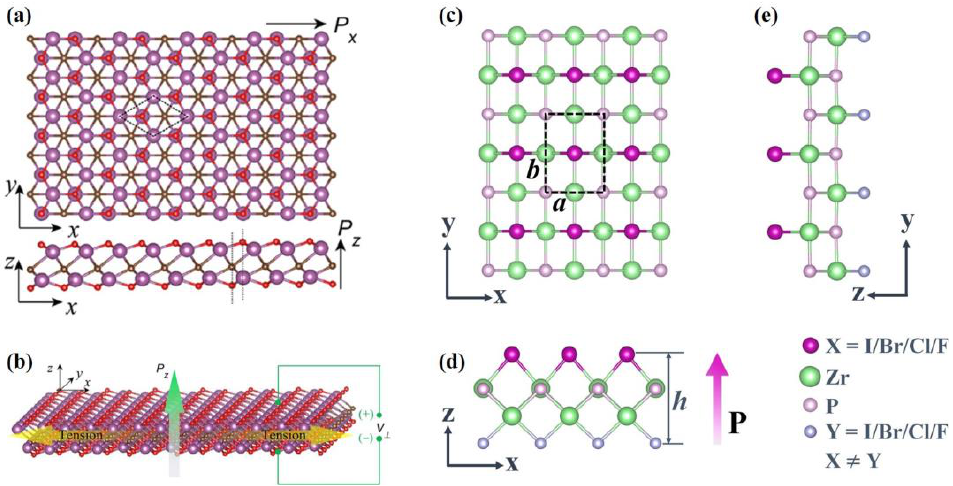
Figure 14. The schematic diagram of the ultrathin out-of-plane films [86,89]. ( a ) Top and side view of Sc 2 CO 2 MXene. Reprinted from [86], copyright 2019, with permission from Elsevier. ( b ) A Sc 2 CO 2 MXene piezoelectric cantilever. Reprinted from [86], copyright 2019, with permission from Elsevier. ( c ) Top view of the Zr 2 P 2 BrCl monolayer. Reprinted from [89], copyright 2023, with permission from Elsevier. ( d , e ) Side view of the Zr 2 P 2 BrCl monolayer from x-z plane and z-y plane. Reprinted from [89], copyright 2023, with permission from Elsevier.